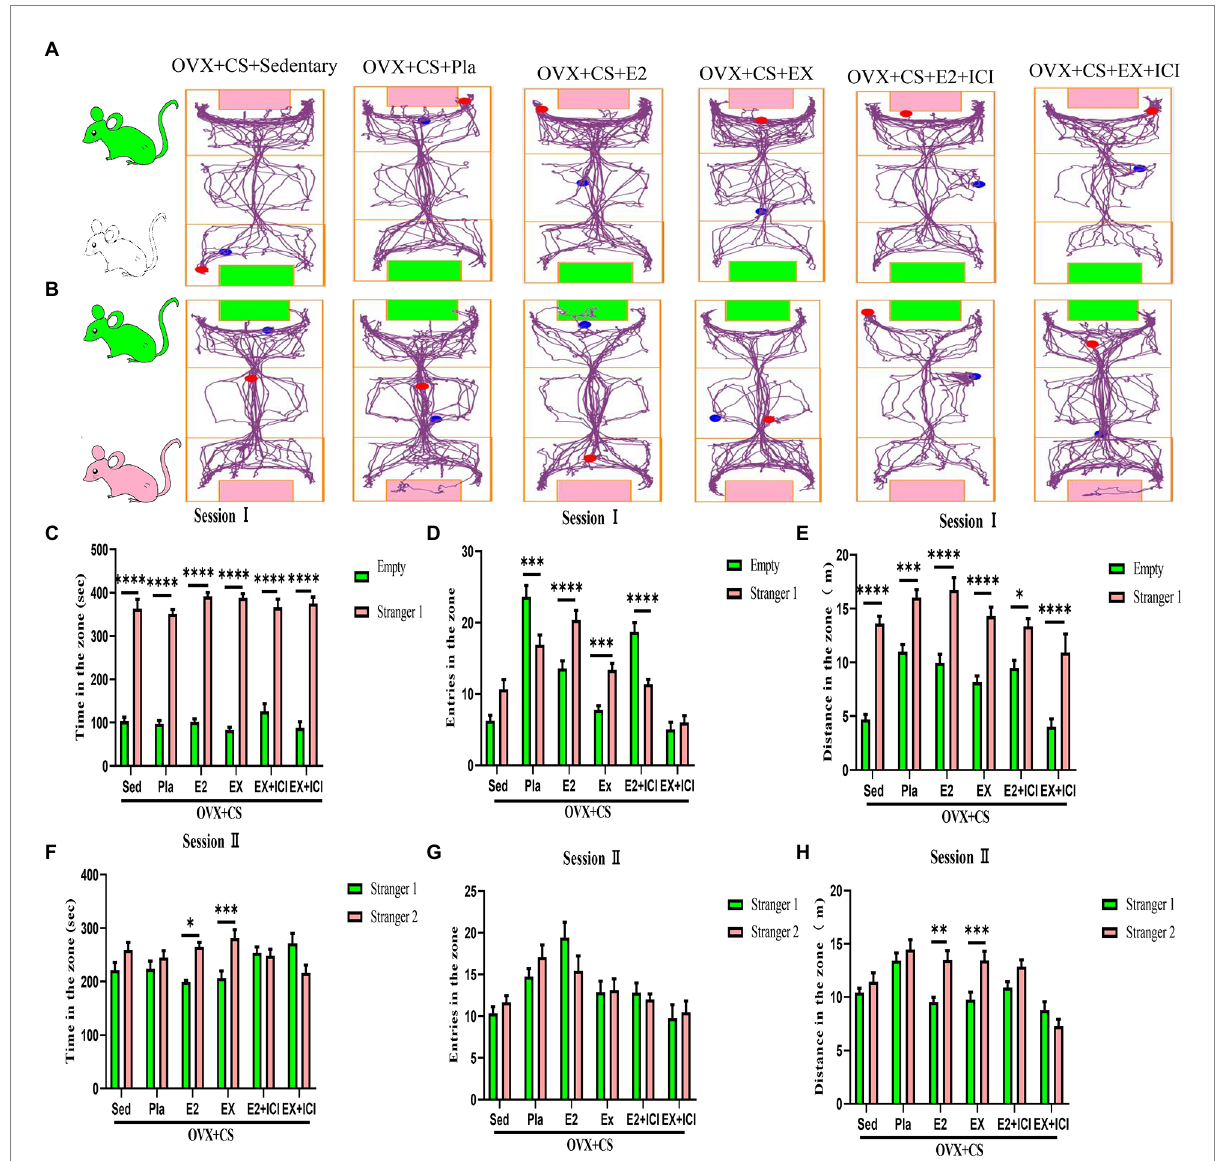
FIGURE 5 Both aerobic exercise and estrogen effectively promoted the recovery of social dysfunction in depressed rats, and the therapeutic effect of aerobic exercise was blocked by the administration of estrogen receptor antagonists. Representative plots of activity trajectories of each group of rats in the three-box social test session I (A) and session II (B) . The activity time (C) , number of entries (D) , and activity distance (E) in the Empty area and Stanger 1 area of the test rats were analyzed for intra- and inter-group comparisons. Intra- and inter-group differences in activity time (F) , number of entries (G) , and number of entries (H) were analyzed for the test rats in the stranger 1 area and the stranger 2 area. All data are expressed as mean ± SEM ( n = 8–12). * P < 0.05, ** P < 0.01, *** P < 0.001, **** P <